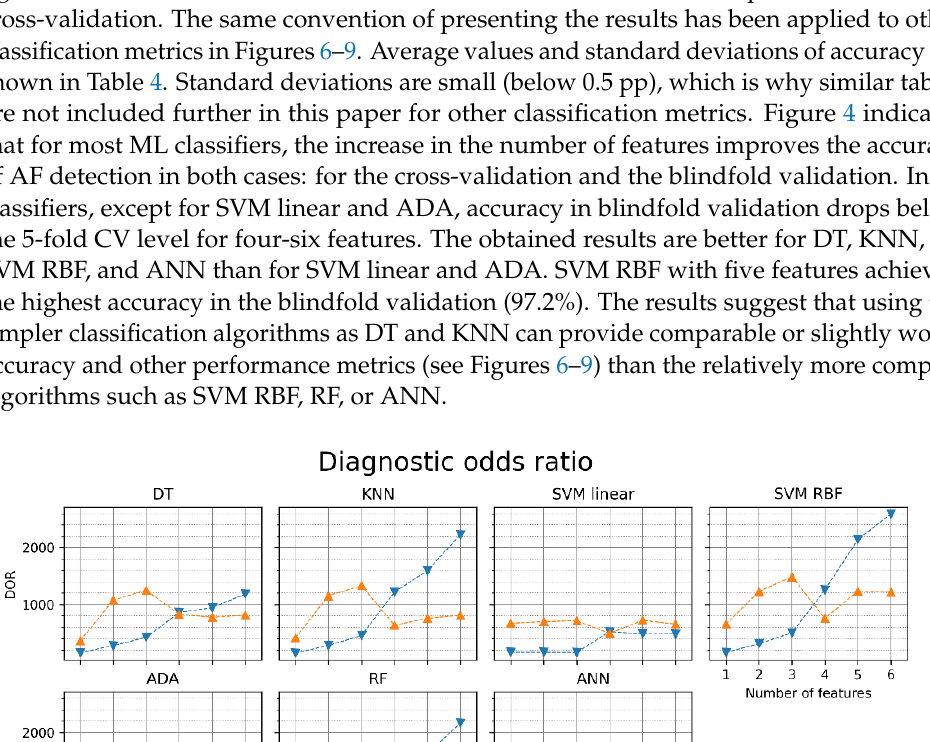
Figure 8. Positive predictive value (PPV) of AF detection for different classifiers with sets of one to six features (orange points — blindfold validation, blue points — 5-fold cross-validation). DT — deci- sion tree, KNN — K nearest neighbors, SVM linear — support vector machine with linear kernel, SVM RBF — support vector machine with radial basis function kernel, ADA — Ada Boost, RF — random forest, ANN — artificial neural network.